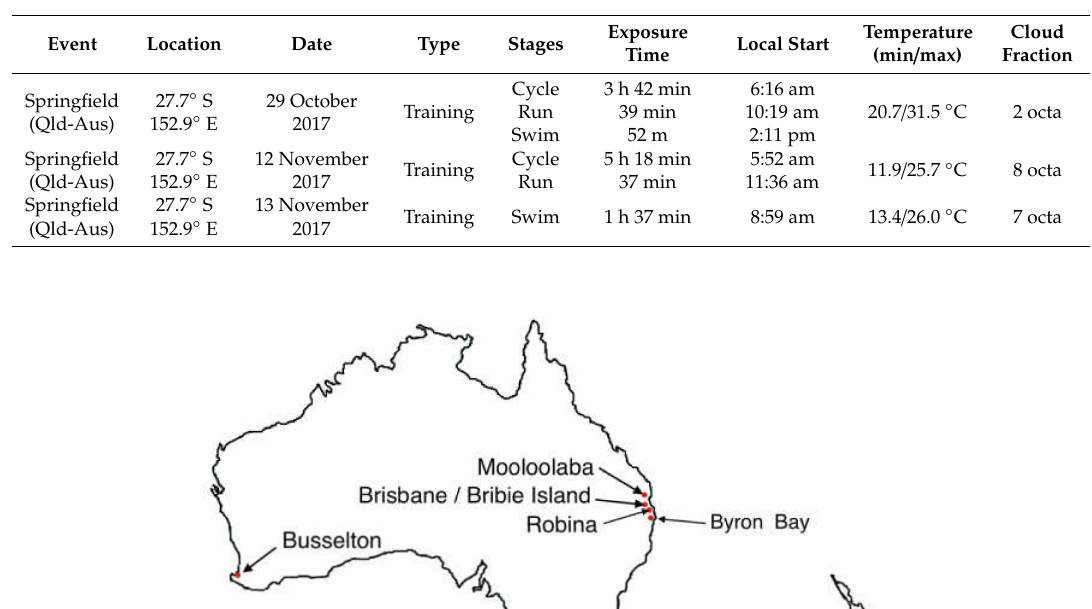
Table 3. Scheduled triathlete training periods in 2017.